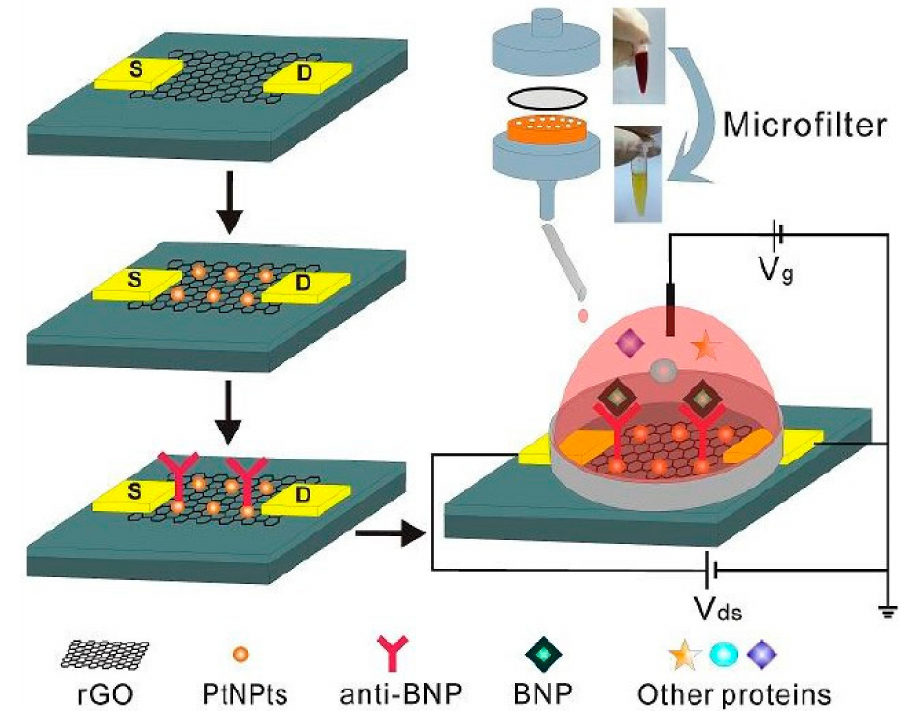
Figure 7. Integration of a custom-made microfilter to platinum nanoparticles (PtNPs)-decorated reduced graphene oxide (rGO) FET biosensors [88]. Reprinted from Biosensors and Bioelectronics,